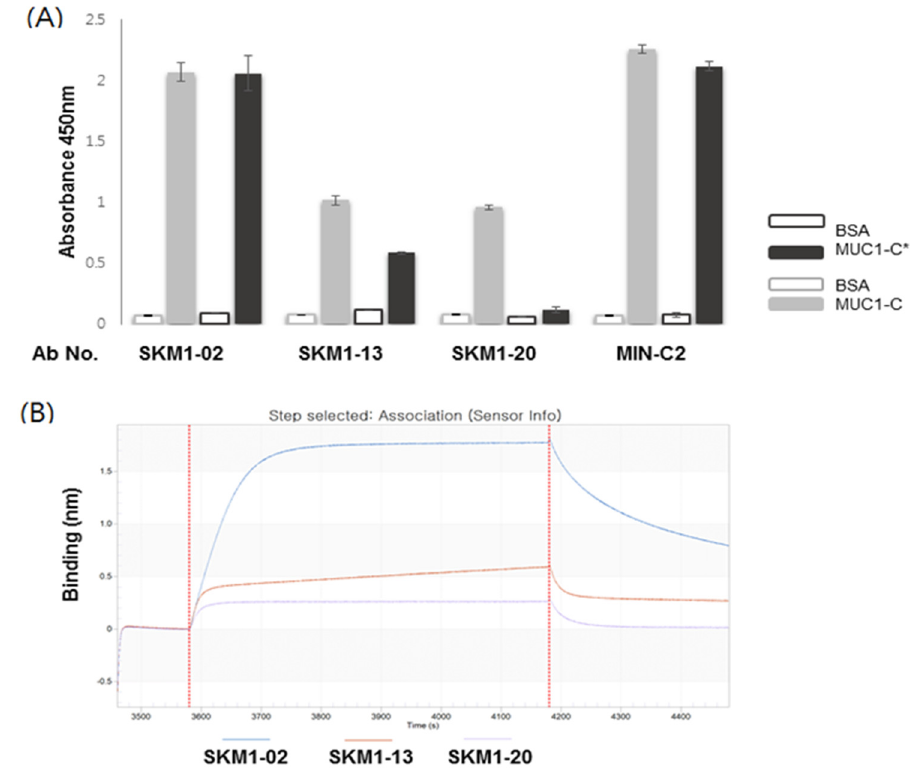
Figure 4. Binding of the SKM1-antibodies with MUC1-C and MUC-1*. ( A ) ELISA represented binding of hMUC1 antibodies with MUC1-C (58 AA) and MUC1-C*(45 AA). Antigens were coated onto 96-well microtiter plates, and then antibodies were incubated. Signals were detected by HRP-conjugated anti-human IgG antibody with colorimetric reagents described in the Materials and Methods. BSA was used as a background control. ( B ) Determination of antibody-binding specificities against MUC1-C antigen using ForteBio’s Octet system. The MUC1-C protein was immobilized on an AR2G sensor chip and three antibody clones showed increased sensorgrams via Octet analysis, reconfirming the characteristic binding on the MUC1-C antigen.